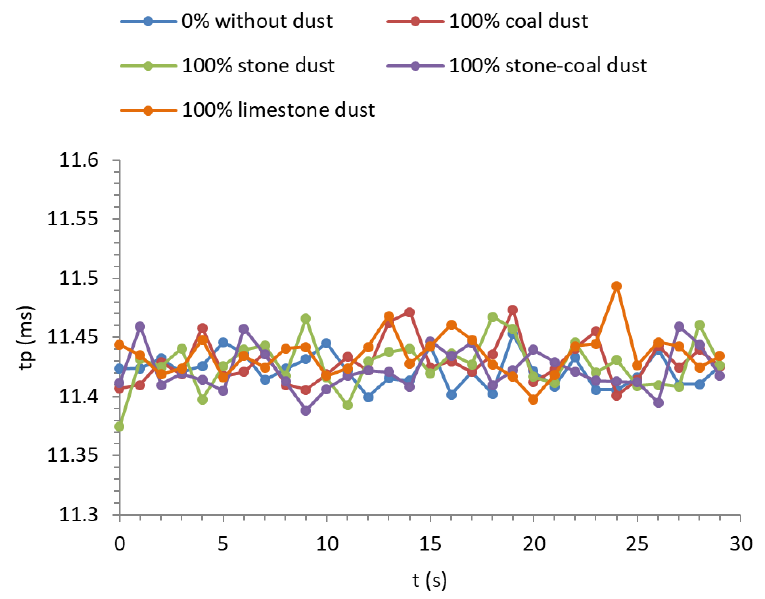
Figure 9. Ultrasonic wave propagation times for various types of dust, AR41 transducers and the wave propagation direction consistent with the airflow.